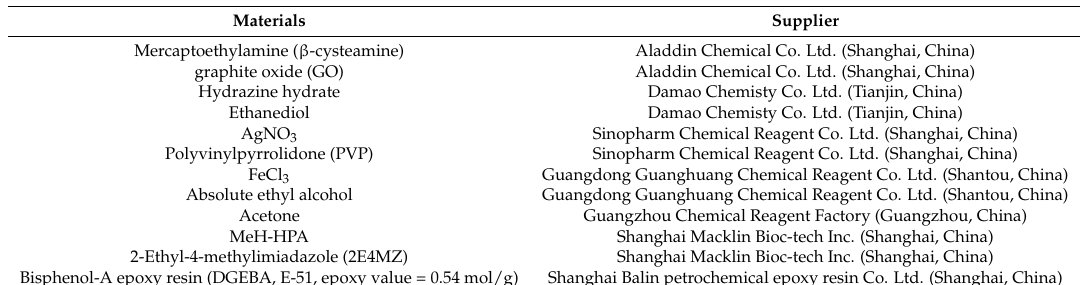
Table 1. Summary of raw